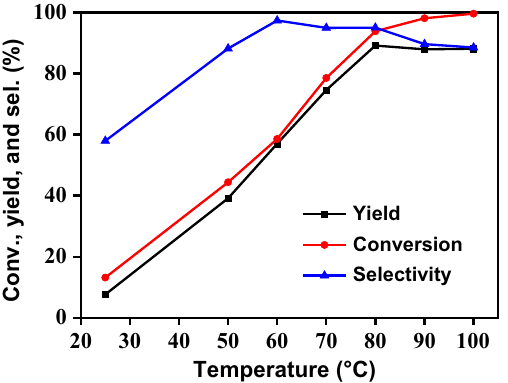
Fig. 3 Influence of the reaction temperatures. Reaction conditions: